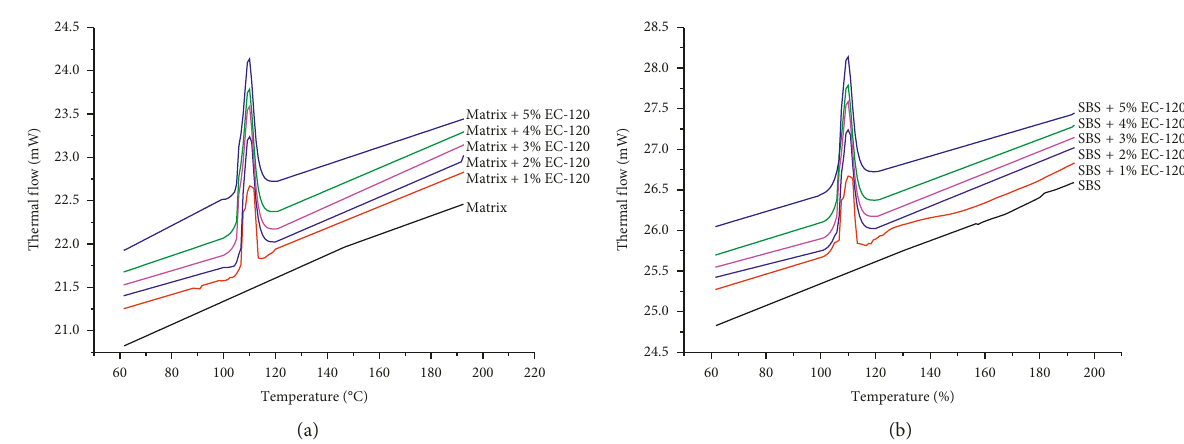
Figure 6: DSC endothermic curve of base binders and WMA binders. (a) Warm-mixed matrix asphalt A-70. (b) Warm-mixed SBS